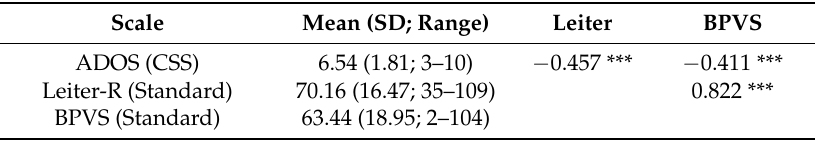
Table 1. Mean levels of autism severity (ADOS), nonverbal functioning (Leiter-R), and verbal functioning (BPVS) and their Pearson